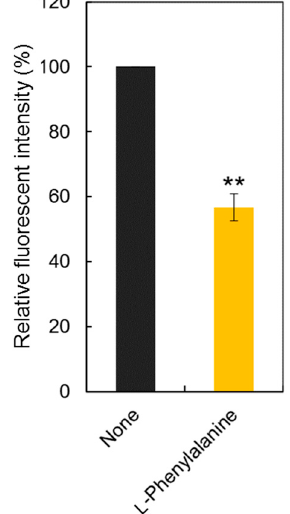
Figure 8. Comparison of fluorescence intensity with/without L -phenylalanine (30 mM). Data are the mean ± S.D. ( n = 3) ** p < 0.01.